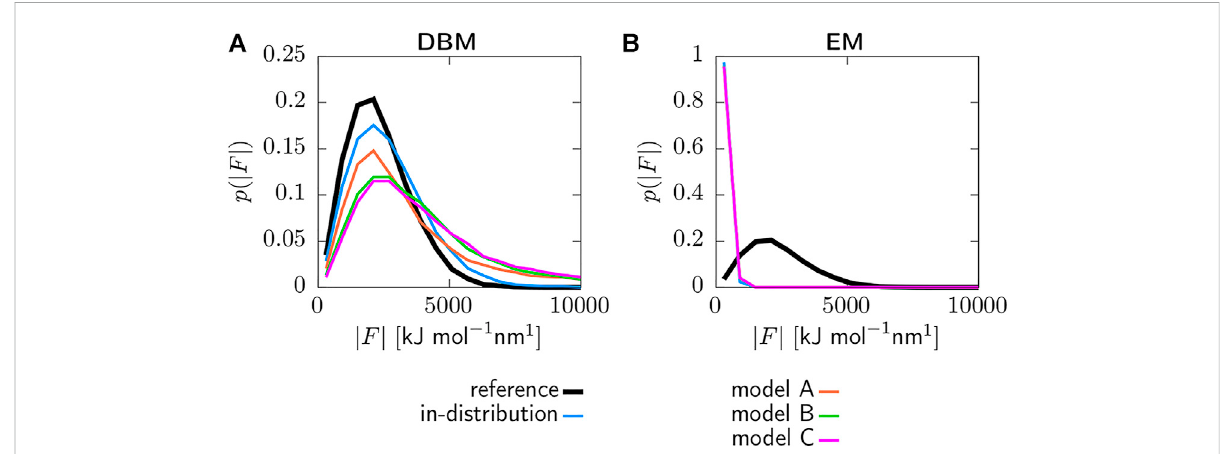
FIGURE 5 Forcedistributionsforreference,backmappedin-distributionandbackmappedgeneralization testsets.BackmappingwithDBM (A) andtheEM scheme (B) . Forces are obtained deploying the AA force fi eld and are projected onto the CG resolution.